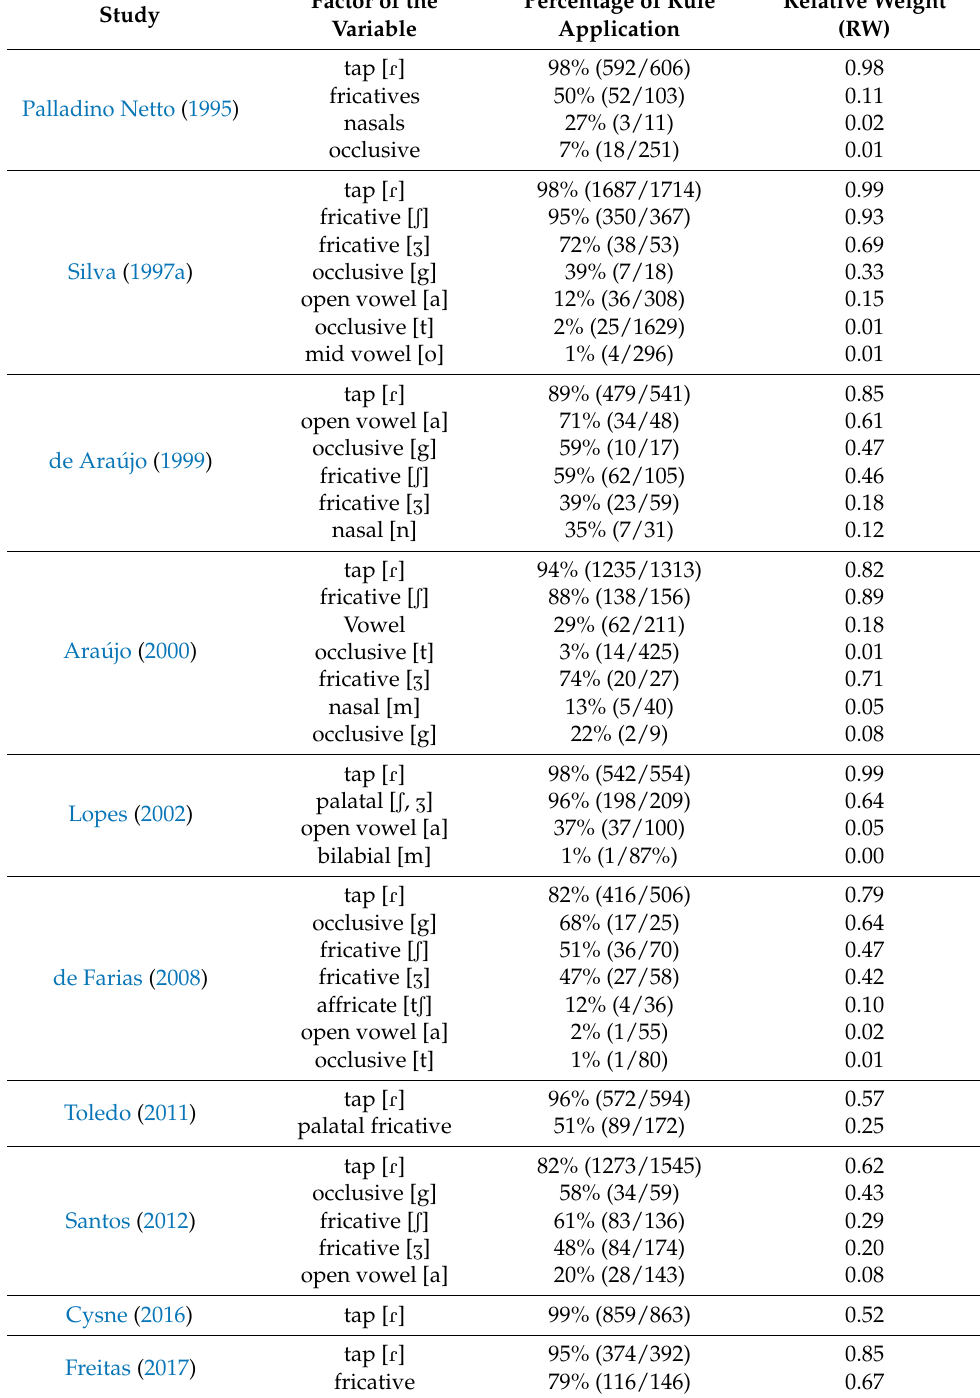
Table 4. Effects of the factors of the variable following